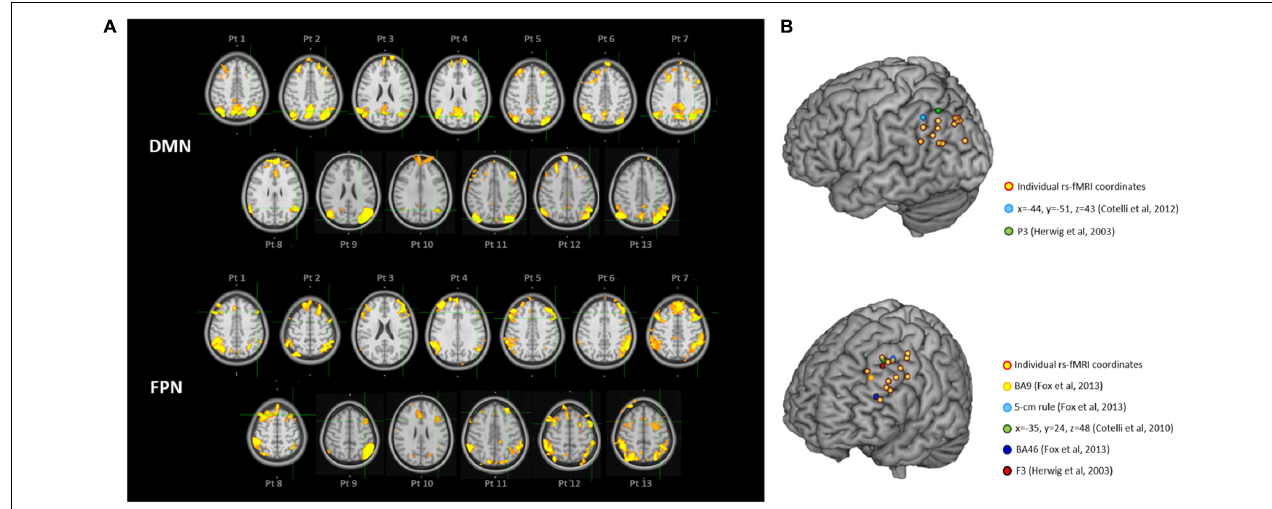
FIGURE 2 | (A) Location of the individual targets (overlaid onto the standard MNI template) for default mode network (DMN) stimulation (top panel) and frontoparietal network (FPN) stimulation (bottom panel) in thirteen AD patients. Images are shown in radiological convention (left denotes right). The individual targets (green cross) were extracted from each subject’s 3T rs-fMRI data using ICA. The DMN targets correspond to the left IPL cluster, the FPN targets to the left DLPFC cluster. The individual DMN and FPN maps are shown in orange-yellow. The targets were defined in subjects’ native T1 space and back-transformed to the standard MNI space for computation and visualization purposes; (B) 3D render showing the individual targets (red-yellow) overlaid onto the standard MNI template. For the DMN, green target corresponds to P3 (Herwig et al., 2003), and light-blue to IPL (Cotelli et al., 2012). For the FPN, yellow target corresponds to DLPFC BA9 (Fox et al., 2013), light-blue to DLPFC-5 cm rule (Fox et al., 2013), blue to DLPFC BA46 (Fox et al., 2013), red to F3 (Herwig et al., 2003), green to DLPFC BA8/9 (Cotelli et al., 2010). DMN, default mode network; FPN, fronto-parietal network; BA8/9, Broadmann areas 8 and 9; BA9, Broadmann area 9; BA46, Broadmann area 46; IPL, inferior parietal lobule; DLPFC, dorsolateral prefrontal